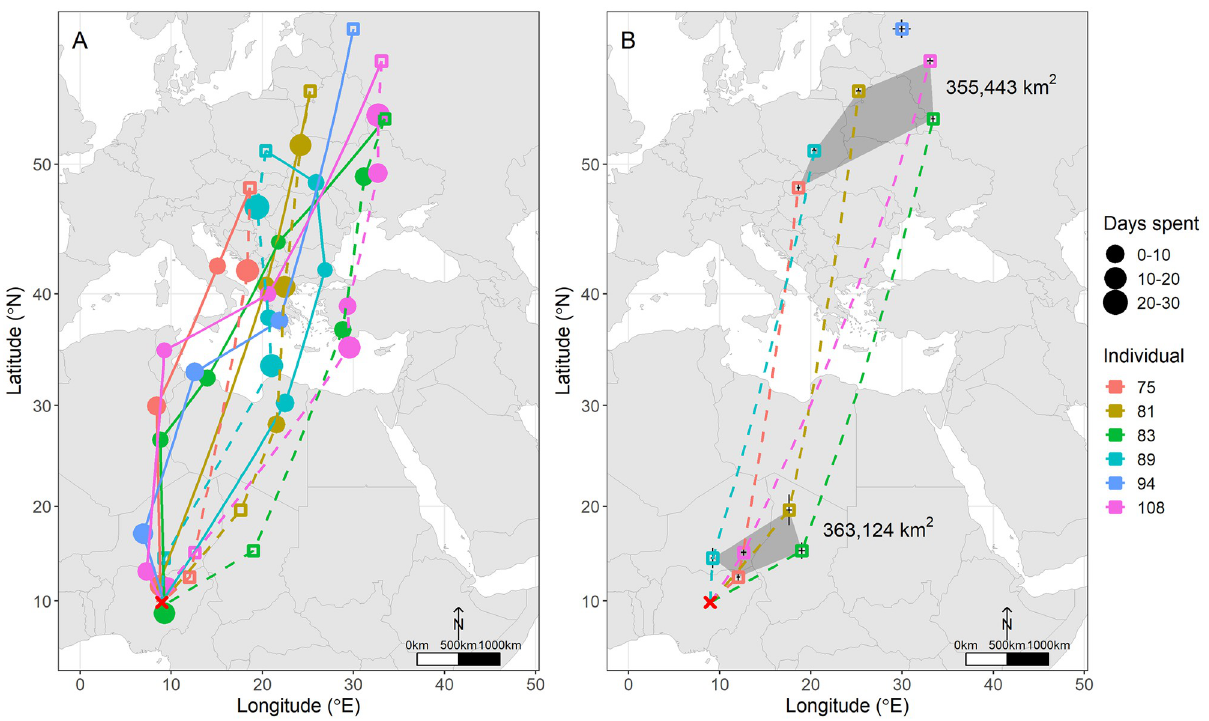
Fig 2. Migratory routes of Common Whitethroats wintering in Nigeria (A) and area utilised during the breeding season and at first wintering grounds (B). Map A shows the migratory routes of Whitethroats wintering in Nigeria. The size of the circle represents the time spent at stopover sites. Lines represent the most direct route from one site to the next during spring (continuous line) and autumn (dashed line) migration. Squares represent breeding grounds (in Europe) and first wintering grounds (in Africa). Map B shows the area utilised during the breeding season and at first wintering grounds. Grey convex polygons represent the connection of outer locations. Lines connect breeding sites with respective first wintering sites and first wintering sites with APLORI (represented with a red cross). Note that because there was no data regarding the first wintering site of individual 094, this individual was excluded from both polygons and area estimates. Sites are shown with standard errors plotted as black asymmetrical crosses. Each colour is a different individual.